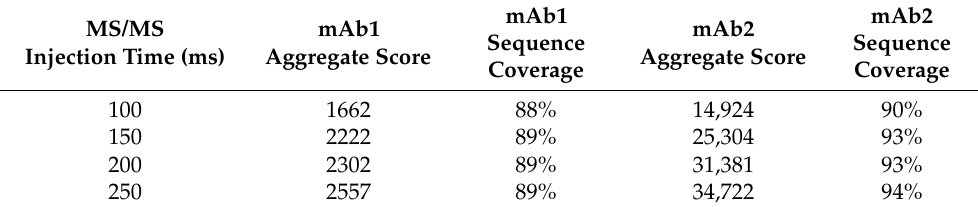
Table 1. Effect of MS/MS Injection Time on Scores and Coverage.